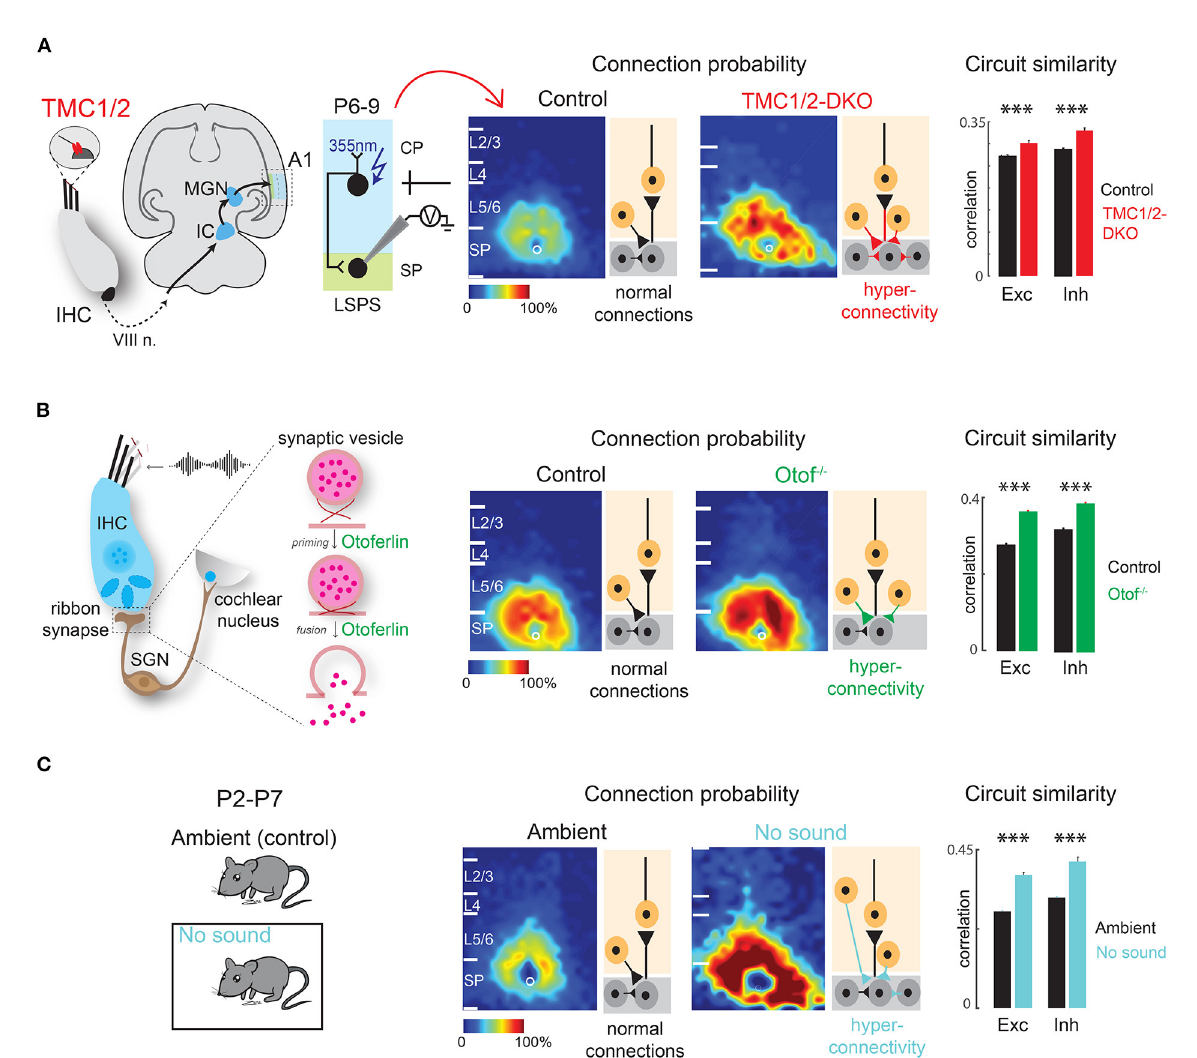
FIGURE4 Early sensory deprivation alters subplate circuits in neonatal mice. (A) Left: Schematic diagram showing location of TMCs on tip link of cochlear inner hair cells. Hair cell activity is transmitted to the primary auditory cortex (A1) via auditory nerve (VIII n.), brainstem nuclei, inferior colliculus (IC), and medial geniculate nucleus (MGN). Middle: laser scanning photostimulation (LSPS) combined with whole cell patch clamp recording reveals hyperconnectivity of subplate neurons in TMC-1/2 DKO mouse pups. Right: Circuit similarity of both excitatory (Exc) and inhibitory (Inh) connections is higher in TMC-1/2 DKO mouse pups [from Meng et al. (2021)]. (B) Left: Schematic diagram showing the role of otoferlin in exocytosis at the ribbon synapses of the inner hair cells. Middle: Otof − / − pups show hyperconnectivity of subplate neurons. Right: Otof − / − pups show increased circuit similarity of both excitatory and inhibitory connections [from Mukherjee et al. (2021)]. (C) Left: Newborn pups were reared in a sound-attenuated chamber from P2–P7 (no sound). Control pups were reared in the normal ambient condition (ambient) in the colony. Middle: Pups show hyperconnectivity of subplate neurons in no sound condition. Right: Pups show increased circuit similarity of excitatory and inhibitory connections in no sound condition [from Meng et al. (2021)]. * p <